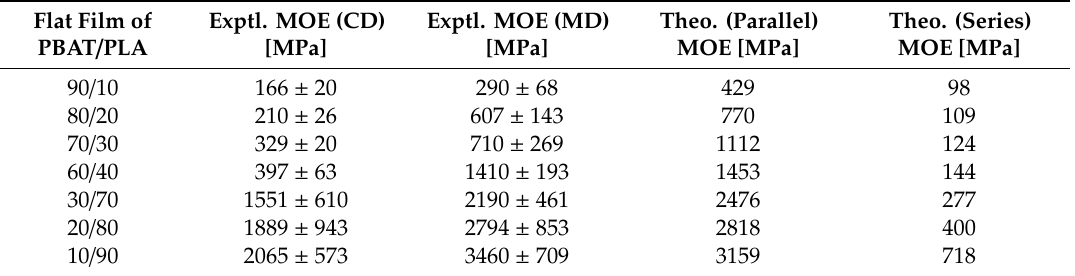
Table 5. Experimental and theoretical modulus of elasticity of flat films made of PBAT / PLA